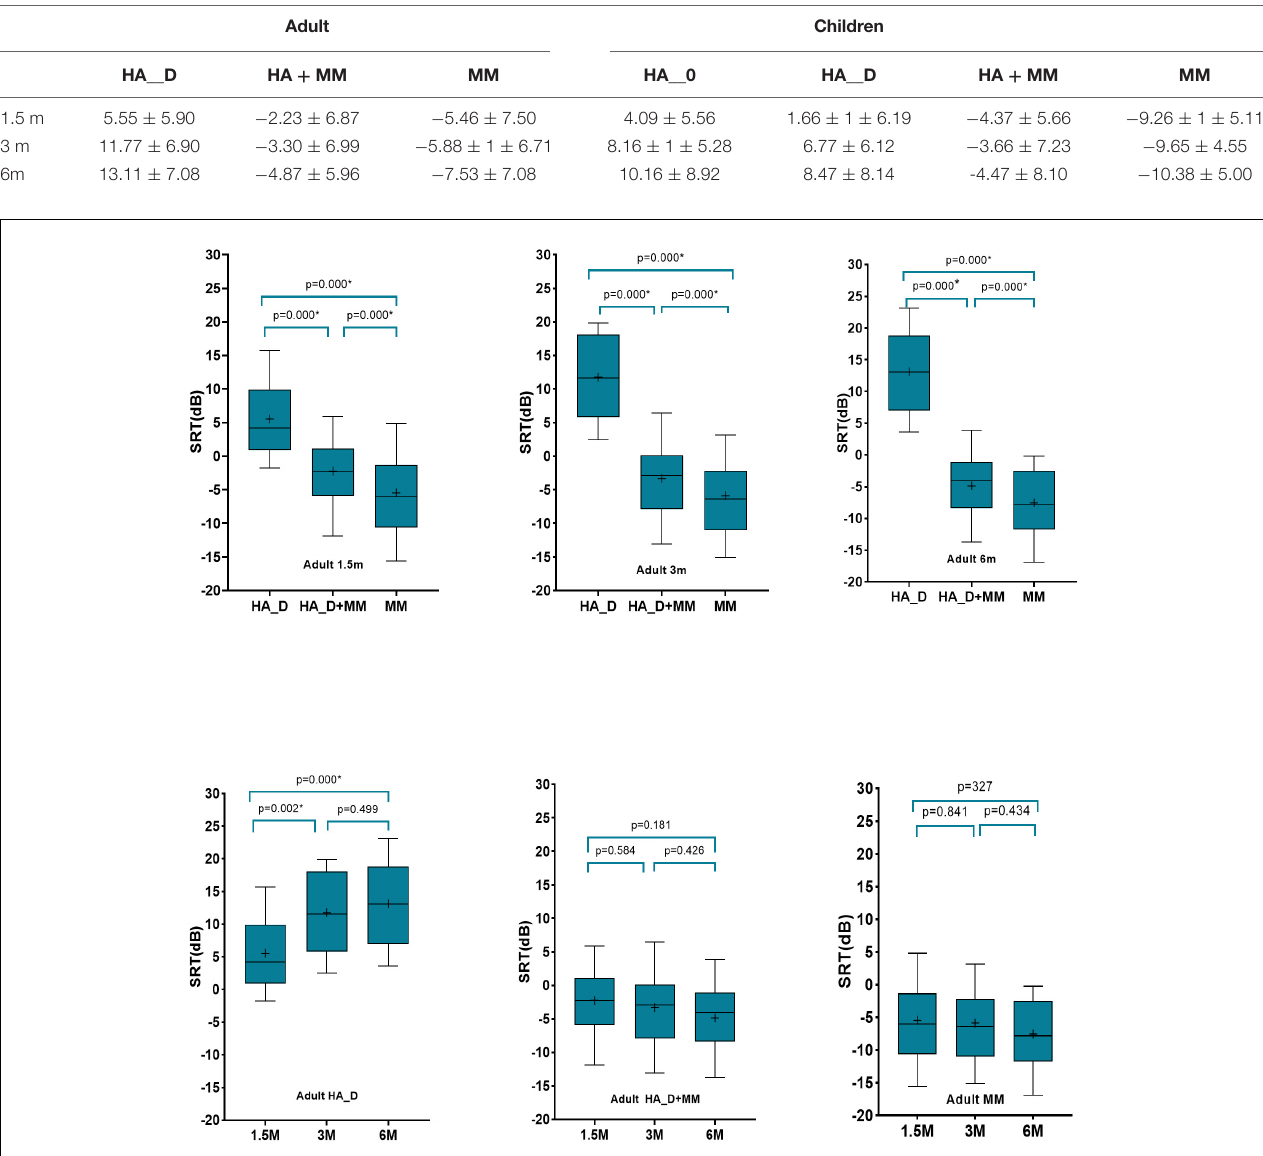
FIGURE 3 | Comparison of speech in noise recognition threshold (measured in SNR) of adult subjects with different test distances and different device settings. Boundaries of the boxes indicate the 25th and 75th percentile. Whiskers indicate the 10th and 90th percentiles. Solid lines denote the median. Plus denotes the